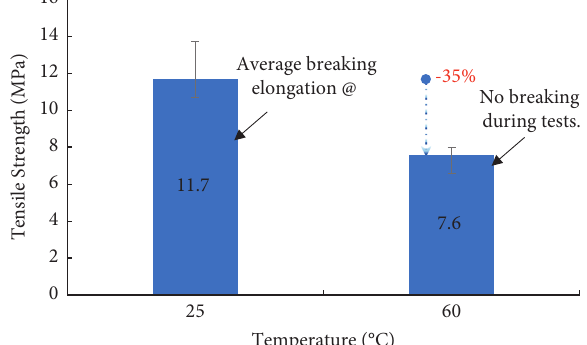
Figure 6: Dumbbell tensile strength test